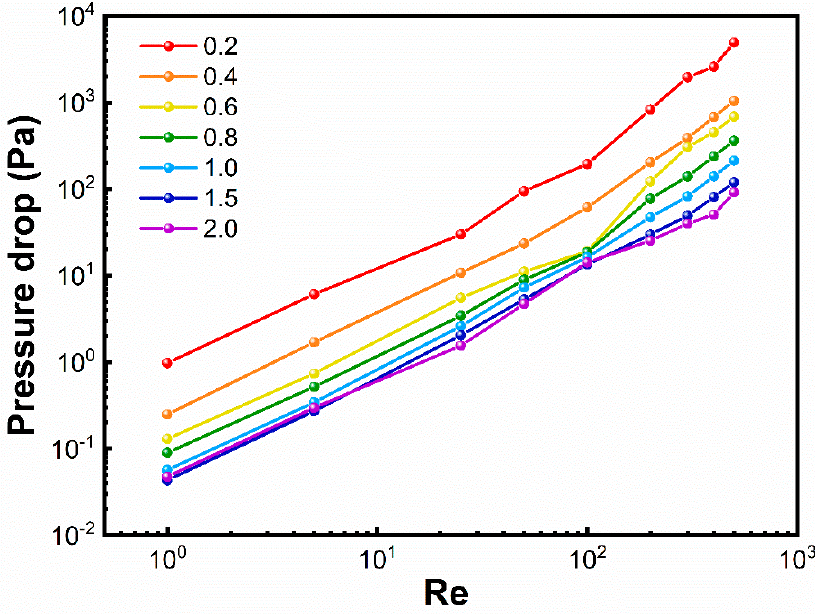
Figure 15. Effect of aspect ratio on pressure drop through the Kenics static mixers at different Re.